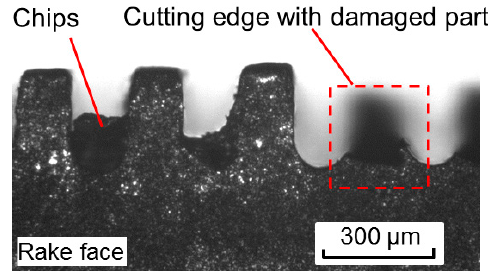
Figure 9. Used tool cutting edge with damaged part.